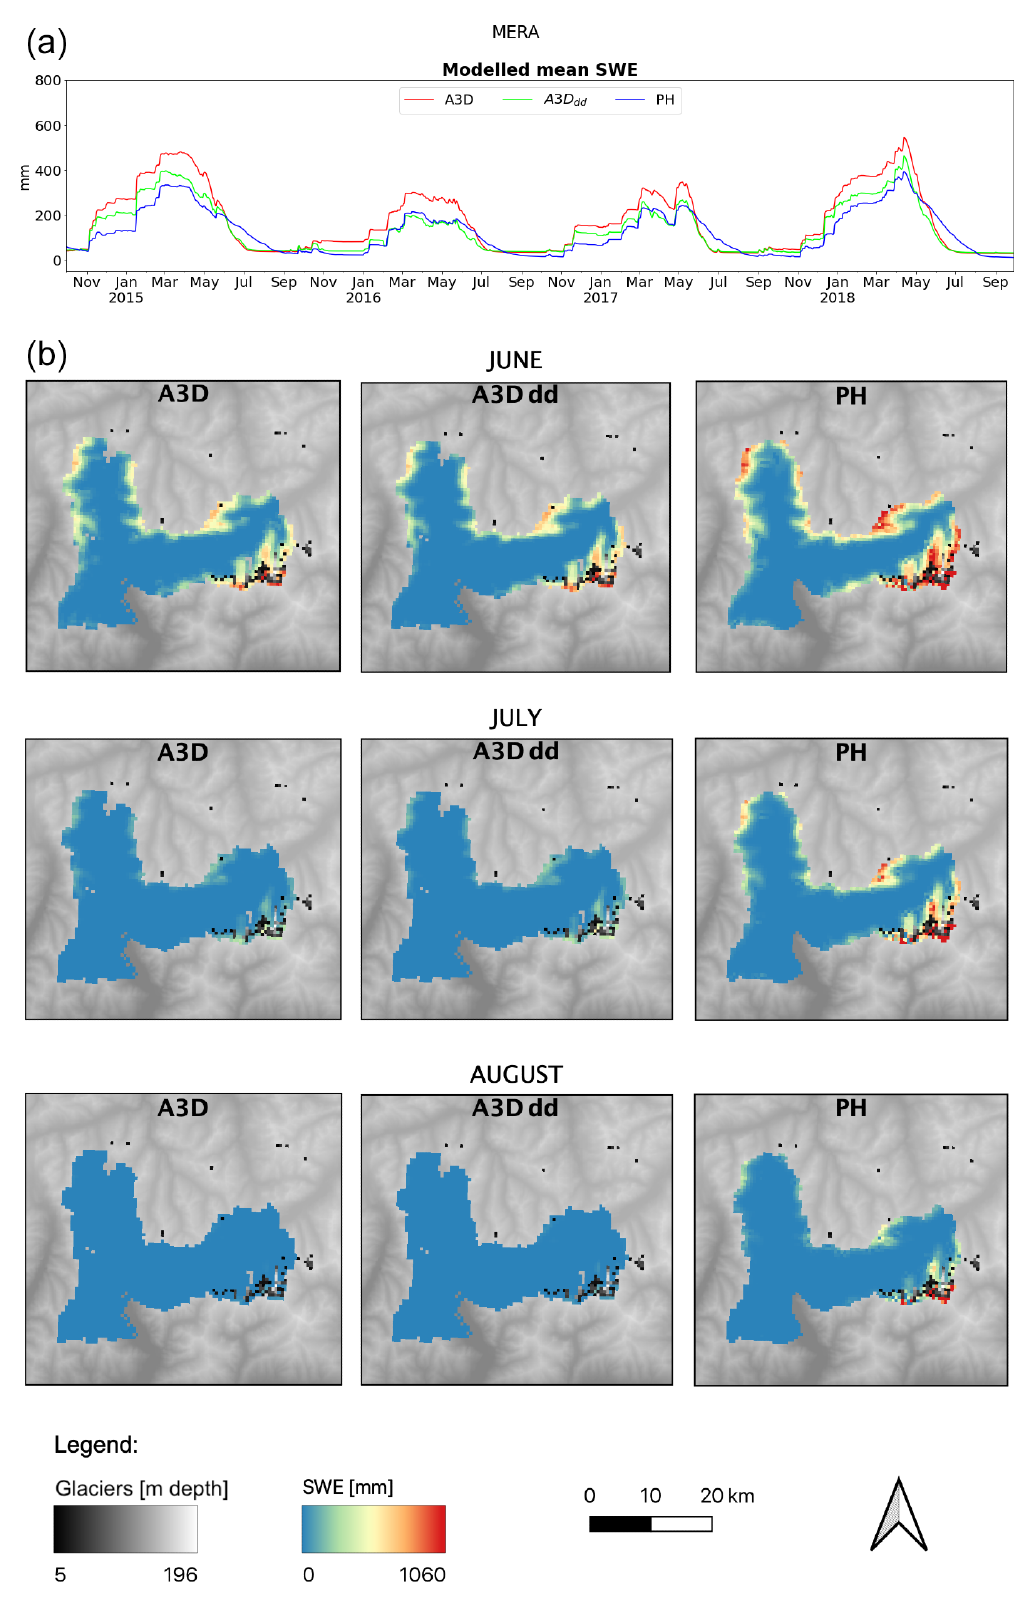
Figure 4. (a) Modelled mean SWE over the Mera basin for the validation period. (b) SWE maps for summer months over the Mera basin for the calibration and validation